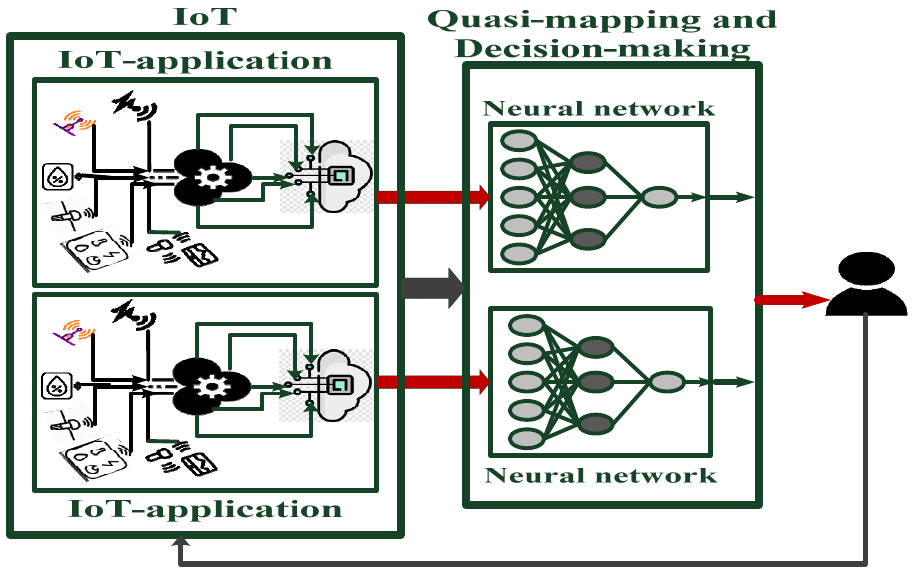
Figure 1 . The work’s steps . Figure 1. The work’s